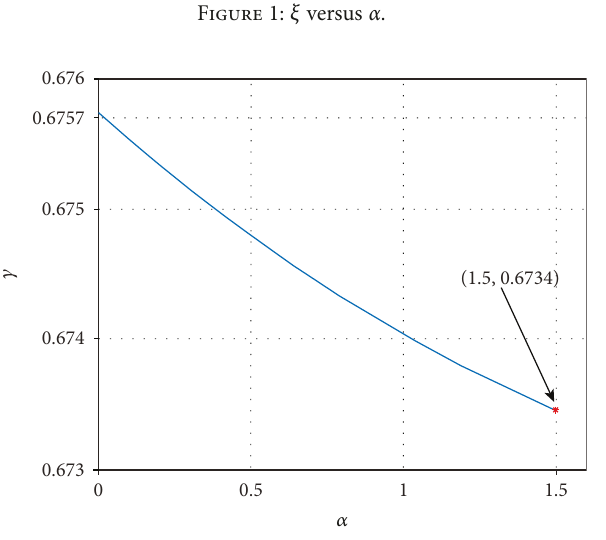
Figure 3: γ versus ξ